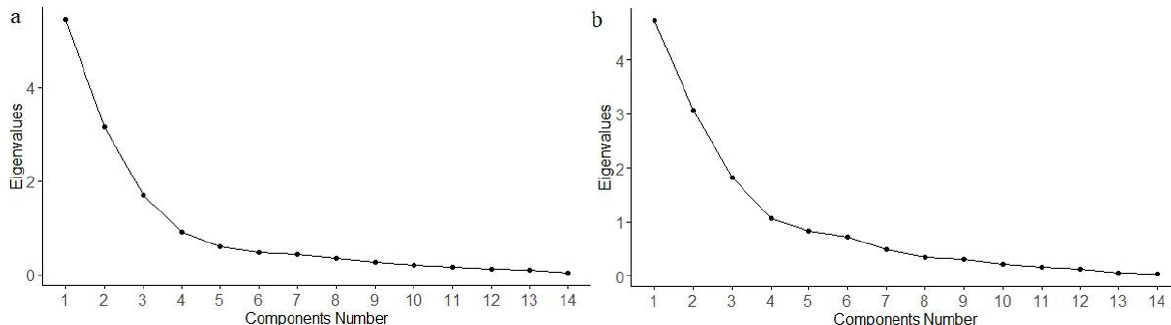
Figure 5. Eigenvalues of the principal components for the dry season (a) and for the rainy season